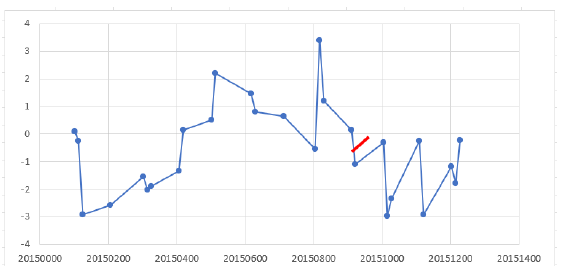
Figure 12. Surface displacement in mm, where there is the collapsed building, the redline indicates the date of